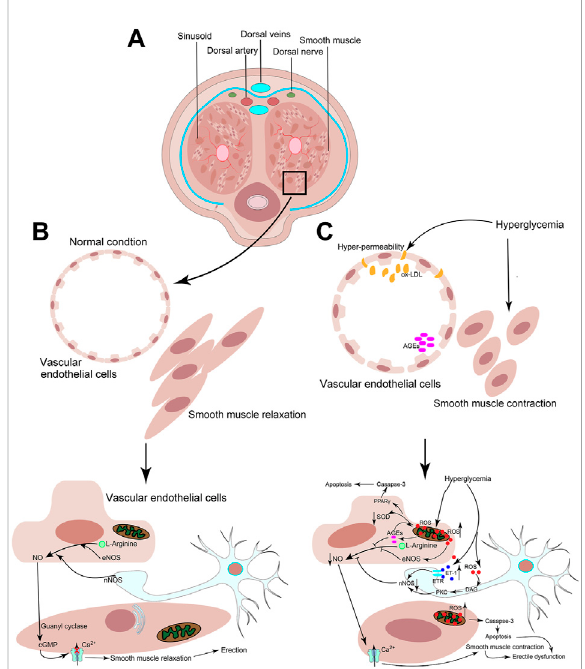
Schematic of the mechanisms involved in the etiology of diabetic vascular complications. (A) Cross-sectional pattern of the penis. (B) Under the physiological conditions, nitric oxide (NO) is generatedbythecorporalendothelialcellsandstimulatesthe smooth muscle to produce cyclic guanosine monophosphate (cGMP), which dilates the vascular smooth muscle of the corpora cavernosa and thereby facilitates the blood supply resulting in erection. (C) Hyperglycemia promotes oxidative stress and the formationofadvancedglycationendproducts(AGEs)andoxidized low-density lipoprotein (ox-LDL). Consequently, the permeability ofthevascularendotheliumandtheproductionofreactiveoxygen species (ROS) are increased. ROS can downregulate NO via inhibiting the activity of endothelial nitric oxide synthase (eNOS). Additionally, the activation of the polyol pathway impairs neurovascular function via suppressing the activity of neuronal nitric oxide synthase (nNOS). Further, the accumulation of AGEs and ox-LDL causes vascular thickening and atherosclerosis in the cavernoussinusoid.Finally,theprolonged oxidativestresscanalso induce